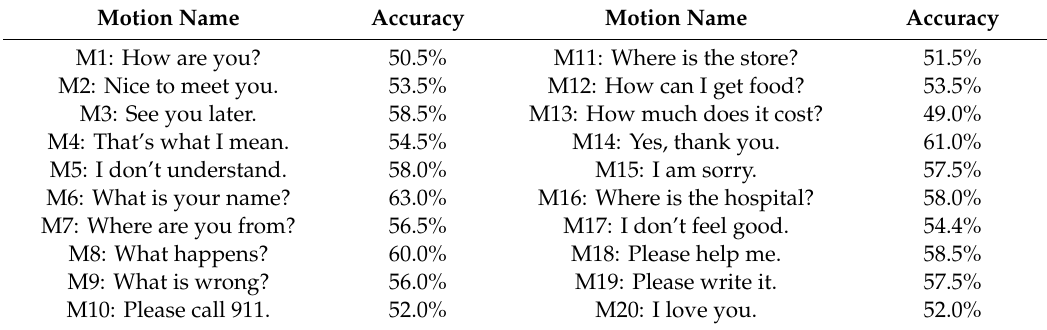
Table 5. The classification accuracy of 20 hand motions on 20 participants.